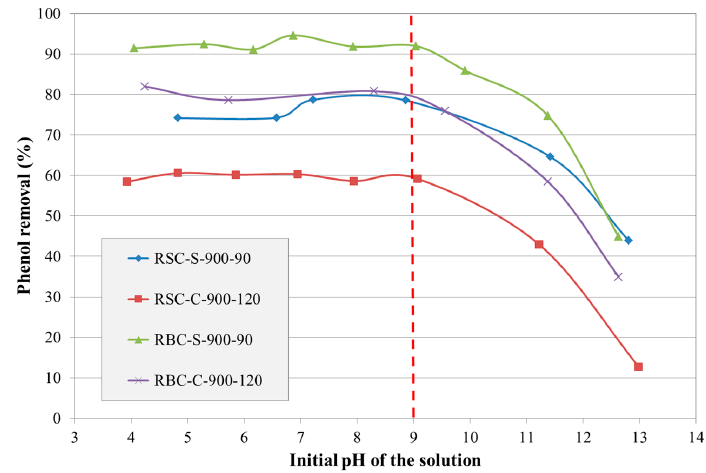
Figure 5. Effect of the initial pH of a solution on the phenol removal by selected ACs derived from RSC and RBC (C 0 = 150 mg/L).